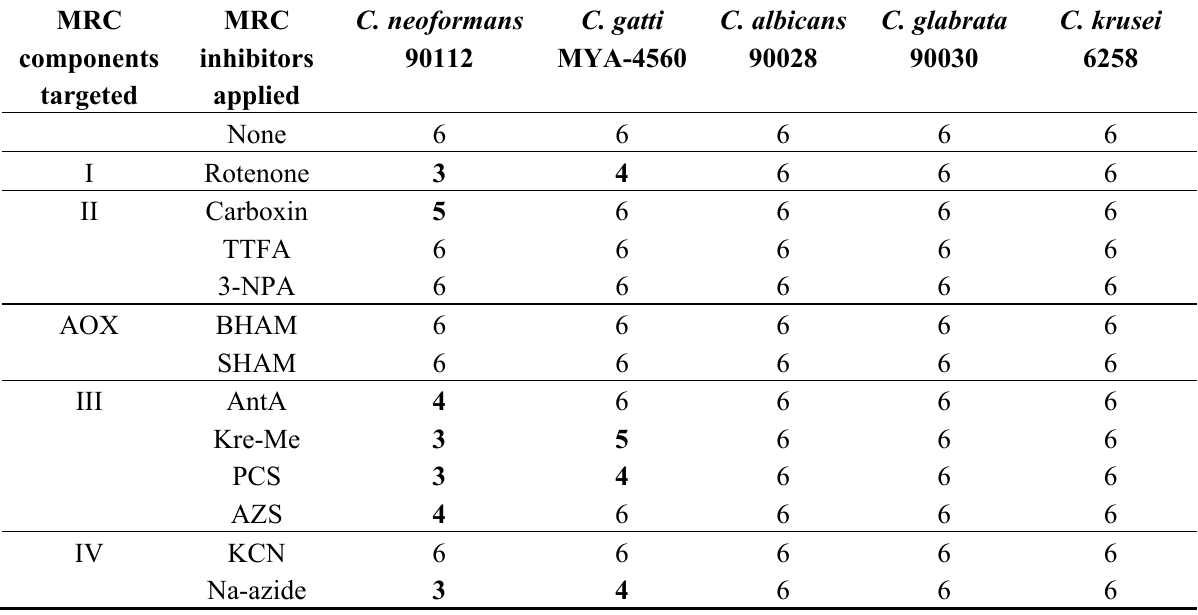
Table 3. Summary of levels of growth inhibition of representative yeast pathogens by MRC inhibitors: agar plate-based yeast dilution bioassays.